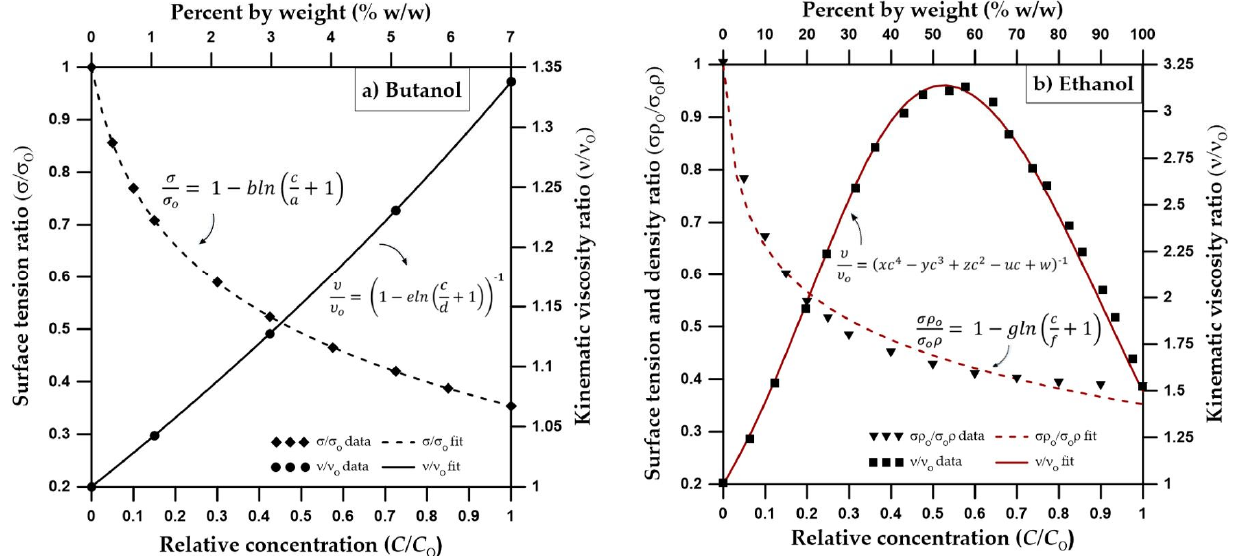
Figure 2. ( a ) Dependence of surface tension and kinematic viscosity on butanol concentration based on [49,68] (surface tension and kinematic viscosity data are from [69]) ( b ) Dependence of surface tension, density and kinematic viscosity on ethanol concentration based on [53], surface tension data are from [70], density data from [71], viscosity data from [53].